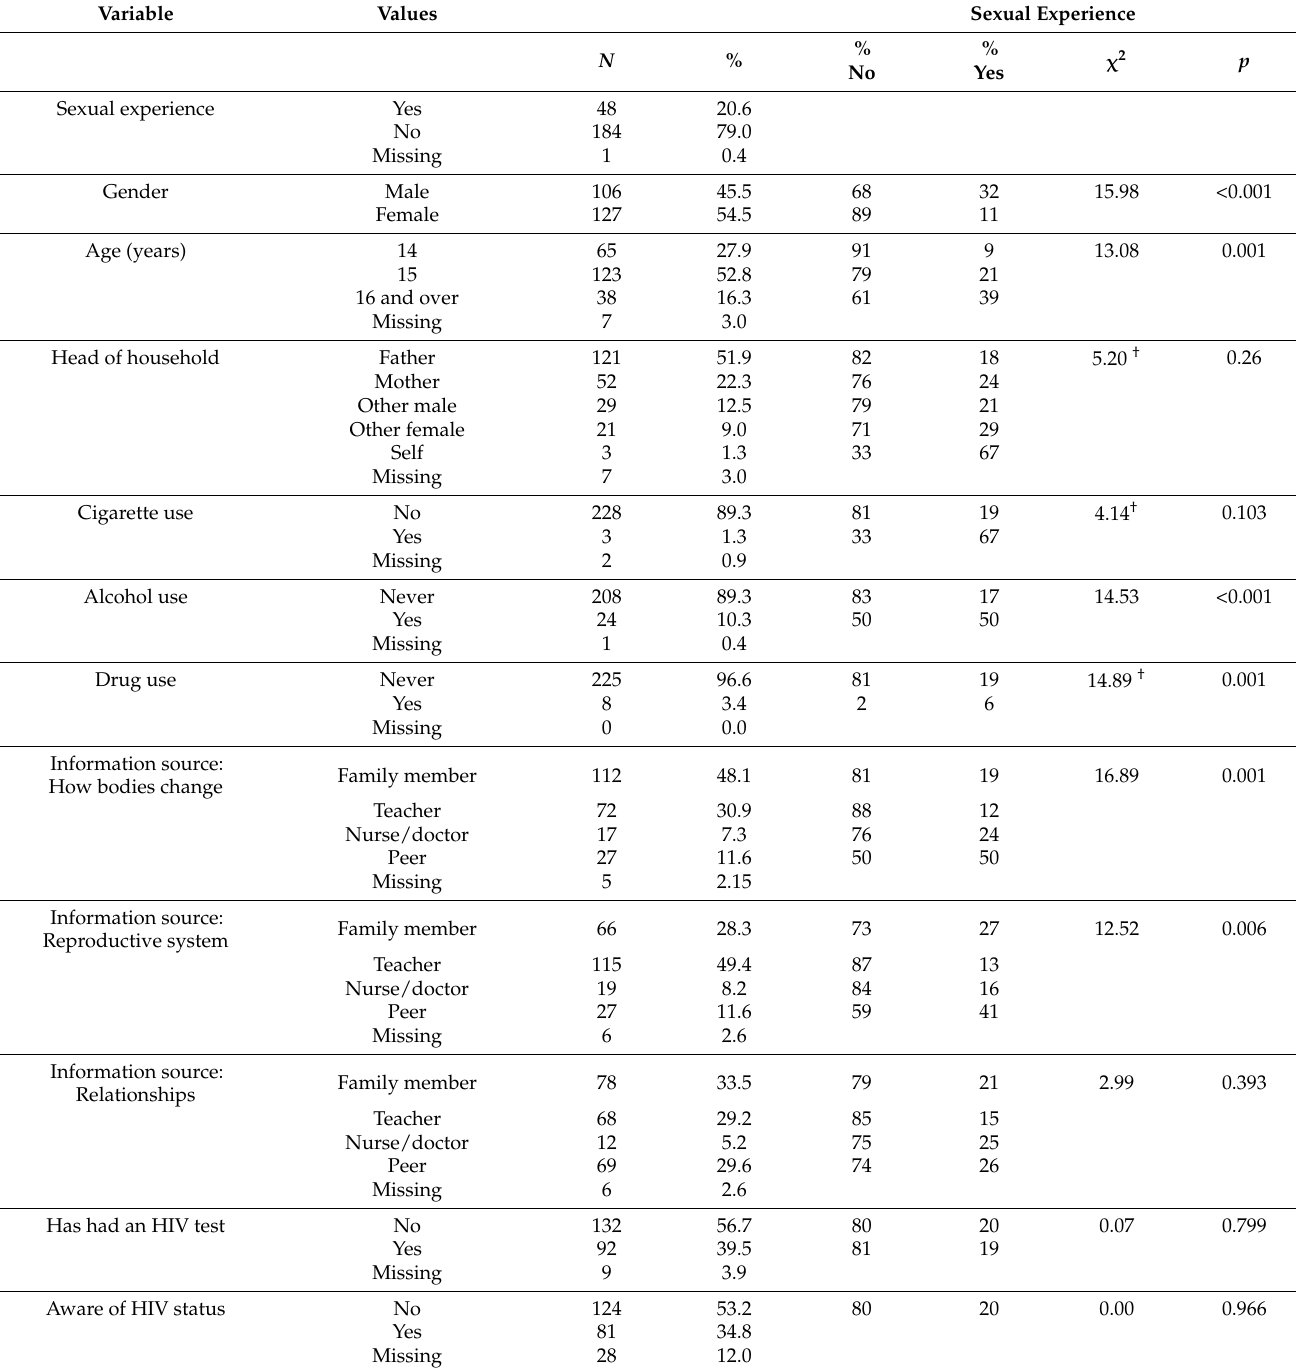
Table 1. Distribution of respondents by sociodemographic attributes and behaviors according to sexual experience of the respondent (N =